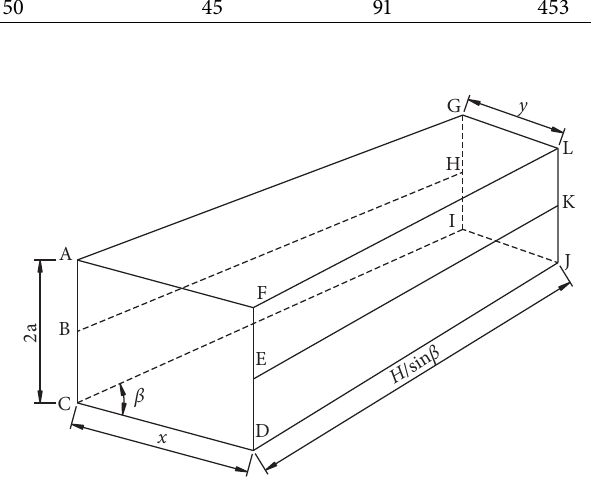
Figure 2: Wedge cut blasting